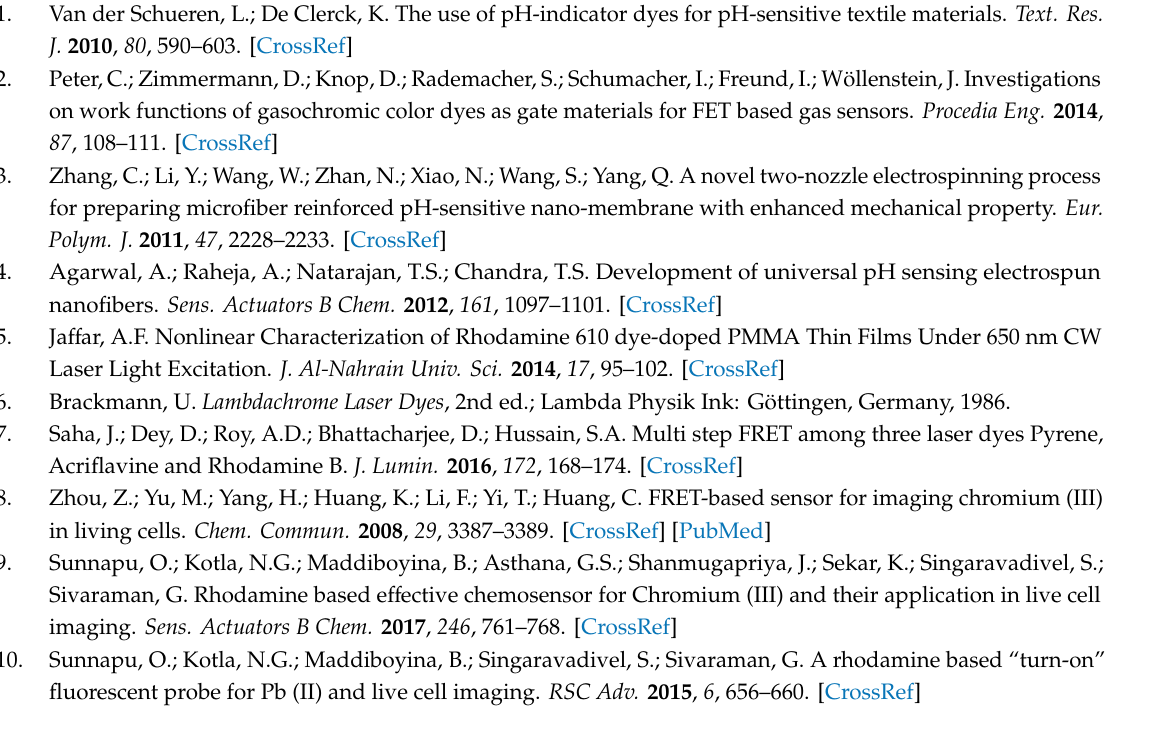
Figure S1: Halochromism of RhYK dye (2.61 × 10 − 4 mol · L − 1 ) in MeOH, Figure S2: Time-dependent color change of dyed sensor for gaseous HCl (10 ppm), Figure S3: Time-dependent color change of printed sensor for gaseous HCl (10 ppm), Figure S4: Color strength changes according to washing and finishing of the dyed sensor: before (dashed) and after (solid) gas exposure, Figure S5: Color strength changes according to washing and finishing of the printed sensor: before (dashed) and after (solid) gas exposure, Figure S6: Time-dependent color change of dyed sensors on exposure to gaseous HCl (10 ppm), Figure S7: Time-dependent color change of printed sensors on exposure to gaseous HCl (10 ppm), Figure S8: Color change of fabricated sensors on exposure to gaseous HCl (10 ppm), Table S1: Sensitive color changes of prototype cloths based on dyed and printed textile sensors when exposed to gaseous HCl (100 ppm), Table S2: E ff ect of VOCs on sensor’s acid gas detection performance (poison e ff